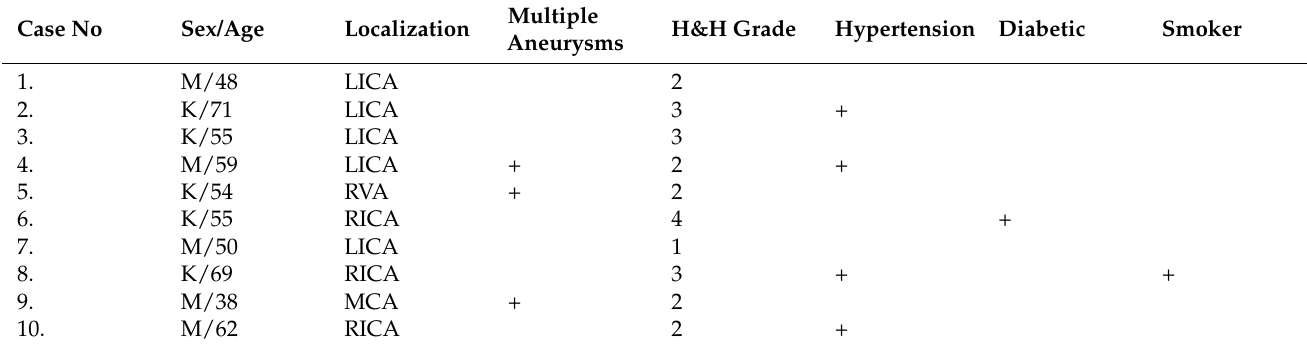
Table 1. The patients’ characteristics.